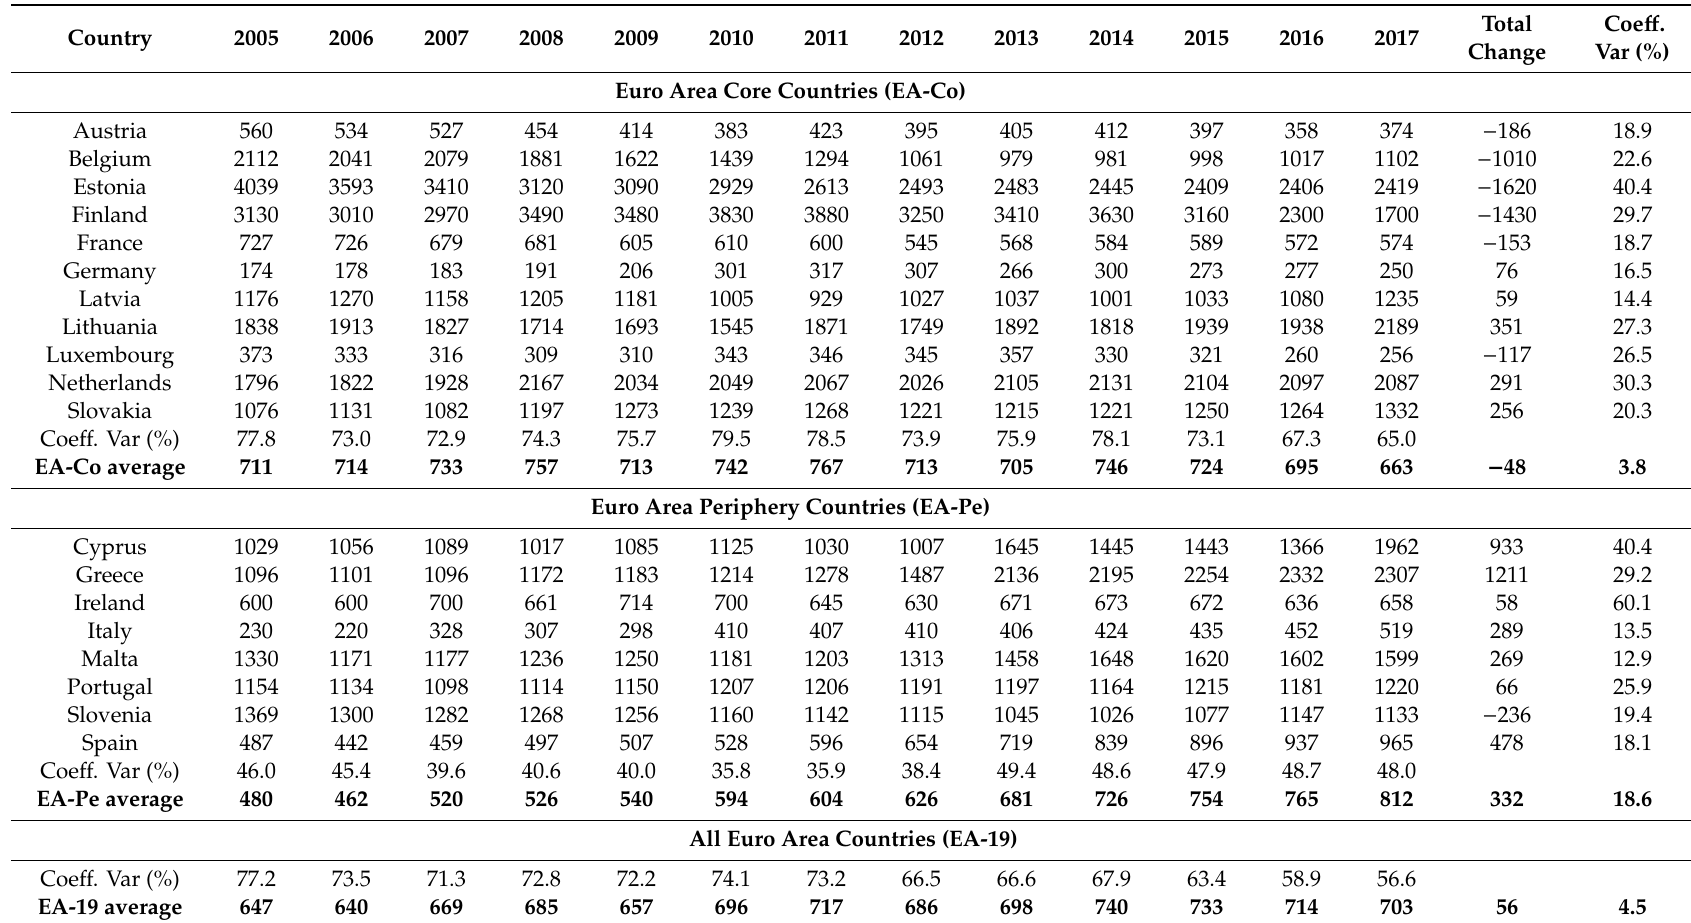
Table 2. Evolution of concentration (Herfindahl–Hirschman Index,